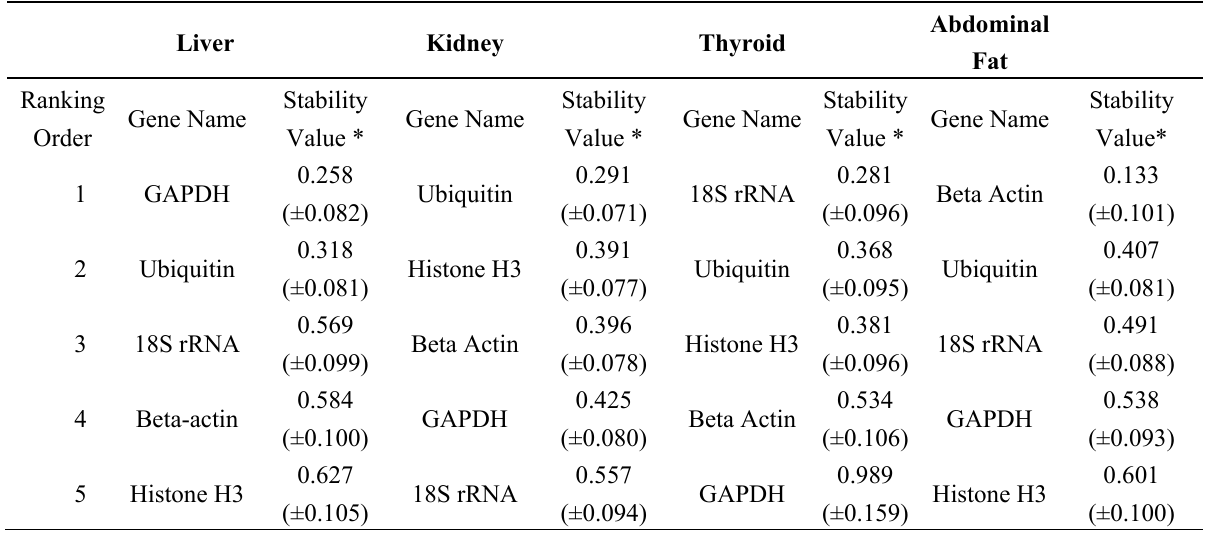
Table 2. Candidate reference genes for normalization of RT-qPCR listed according to their expression stability calculated by NormFinder VBA.